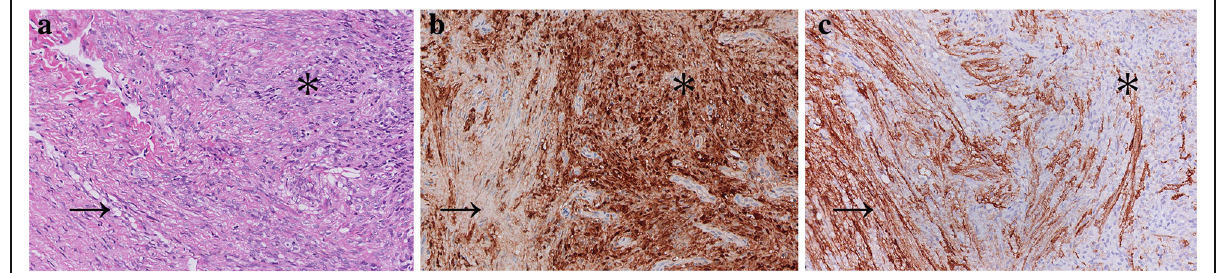
Fig. 3 The boundaries of two morphological components in hypocellular areas. a . The epithelioid cells (black asterisk) and elongated spindle cells (black arrow) composed of the hypocellular areas. Haematoxylin-eosin staining, 200x magnification. b-c. The blurred boundaries of two morphological areas were demonstrated by non-overlapping staining of S-100( b ) and EMA( c ) in the same field as Fig. 3a. Immunohistochemical staining, 200x